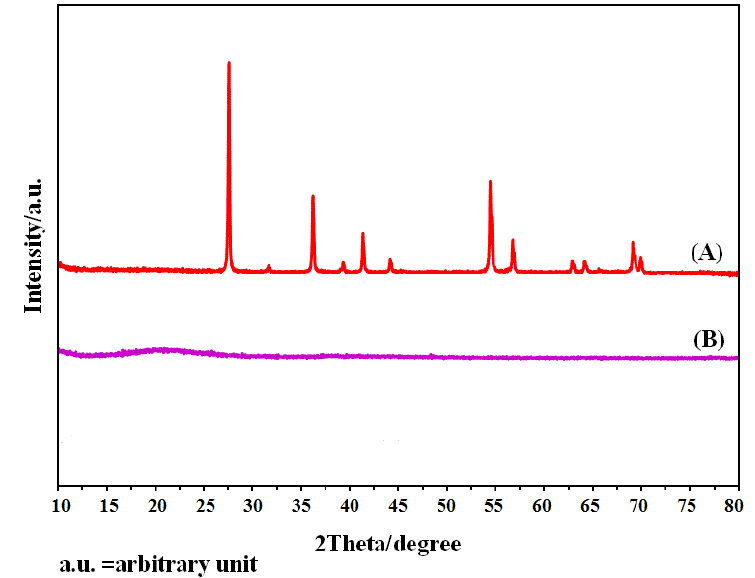
Figure 6. X-ray diffraction patterns of ( A ) pure TiO in 1.0 × 10 −2 M TiCl 3